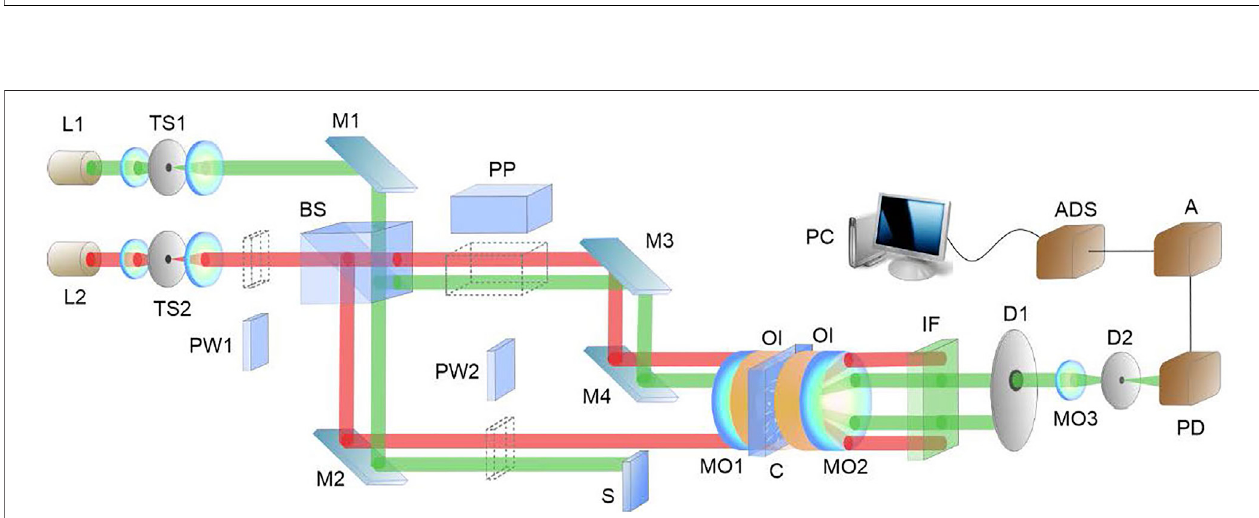
FIGURE 6 | The experimental equipment layout: L1, L2, lasers; TS1, TS2, telescopic systems; N 1, N 2, N 3, N 4, mirrors; PW1, PW2, half-wave plates for λ = 635 nm;PP,plane-parallelplate;MO1,MO2,micro-objectives; S ,cuvette withtheAuhydrosol; IF,interference fi lterwithmaximumtransmissionat λ =532 nm;D1,D2, diaphragms; S, opaque screen; PD, photodetector; A , ampli fi er; A DC, analog-digital converter; PC, computer.